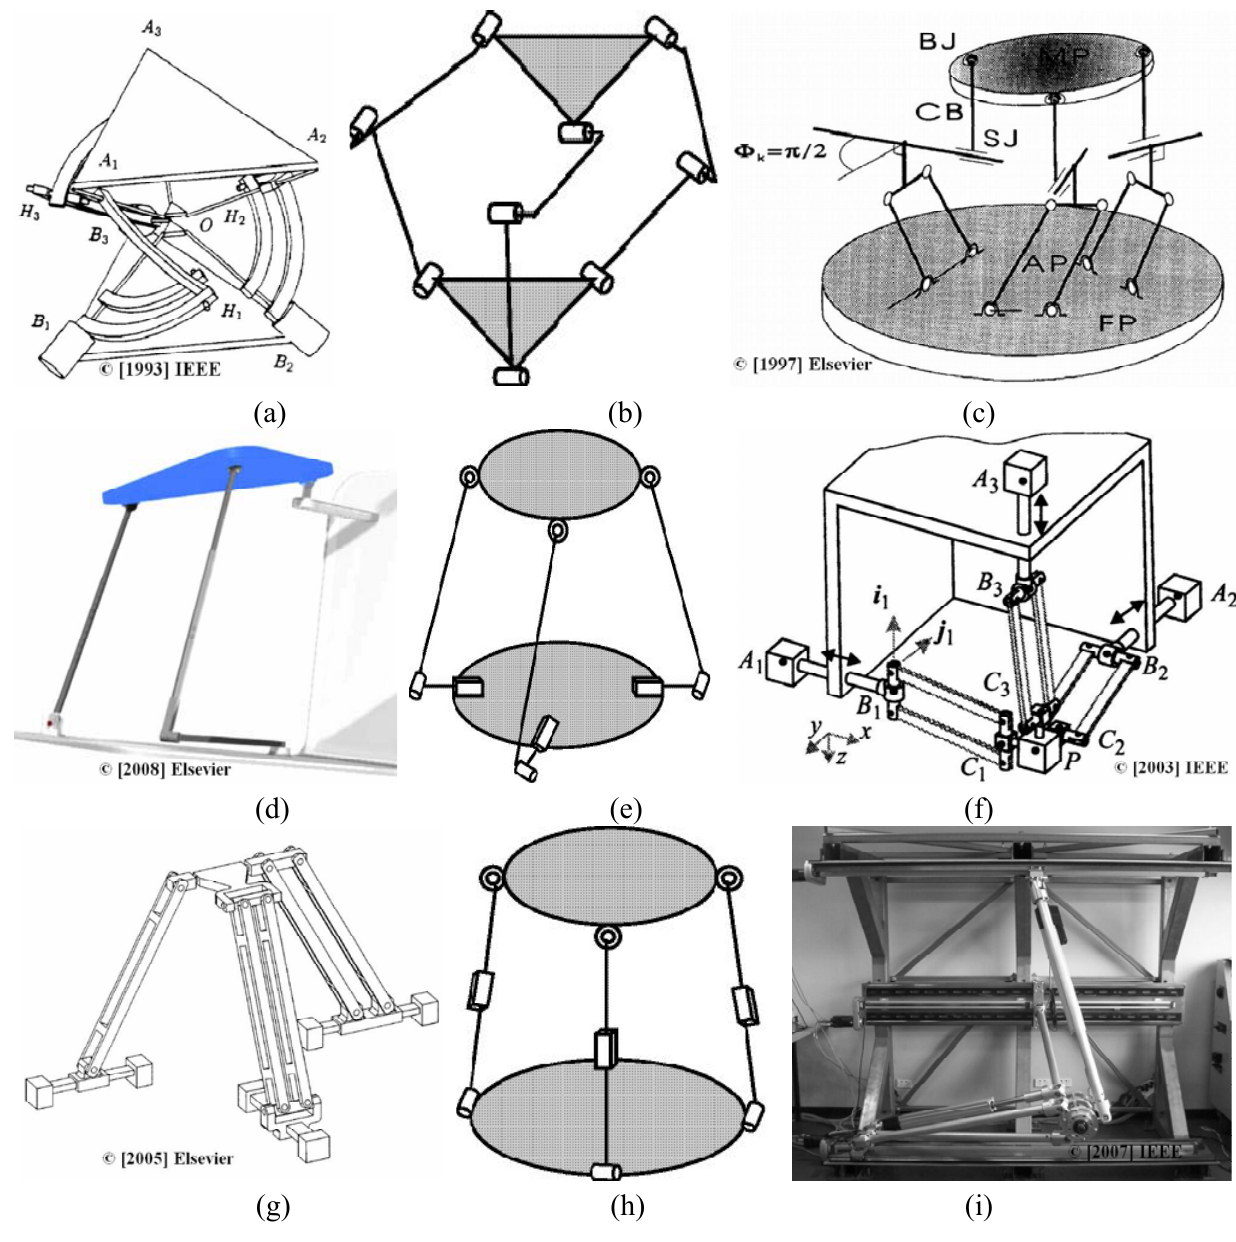
Figure 2. Three-DOF parallel robots: (a) Gosselin design (reprinted from [19] with permission from IEEE). (b) Tsai design [20]. (c) Ceccarelli design (reprinted from [21] with permission from Elsevier). (d) Gallardo design (reprinted from [22] with permission from Elsevier). (e) Carretero design [23]. (f) Ortoglide from Chablat (reprinted from [24] with permission from IEEE). (g) HALF-II from Liu (reprinted from [25] with permission from Elsevier). (h) Gallardo design [26]. (i) Tyapin design (reprinted from [27] with permission from